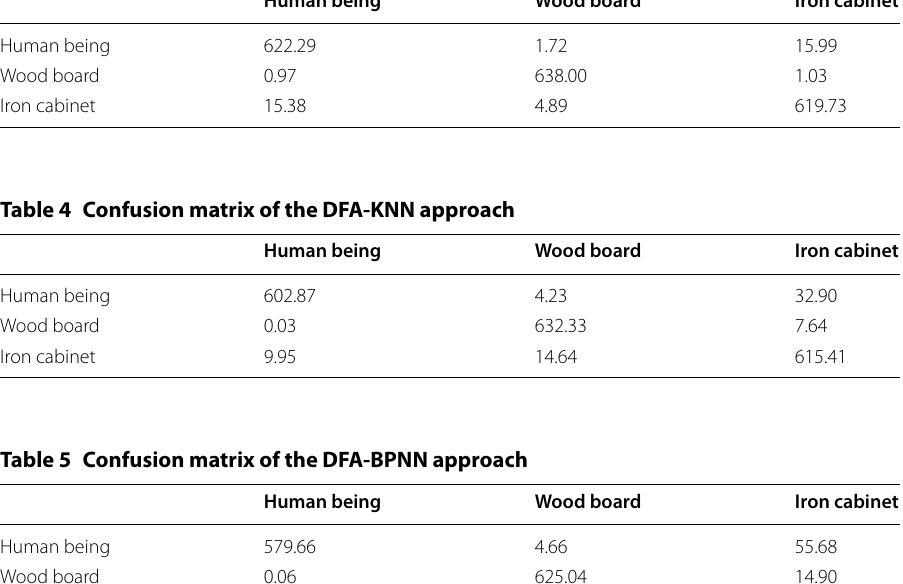
Table 3 Confusion matrix of the DFA-SVM approach Human being Wood board Iron cabinet Human being 622.29